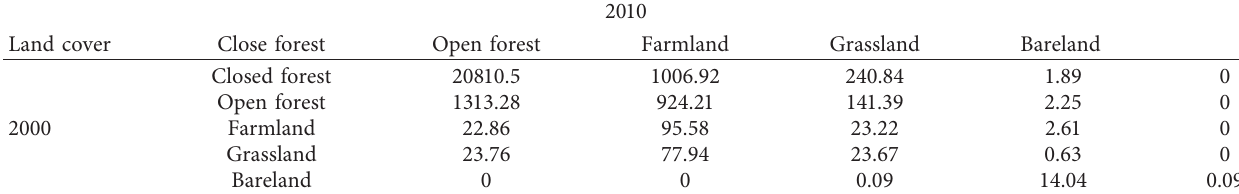
Table 11: 2000–2010 forest to farmland conversion in hectares